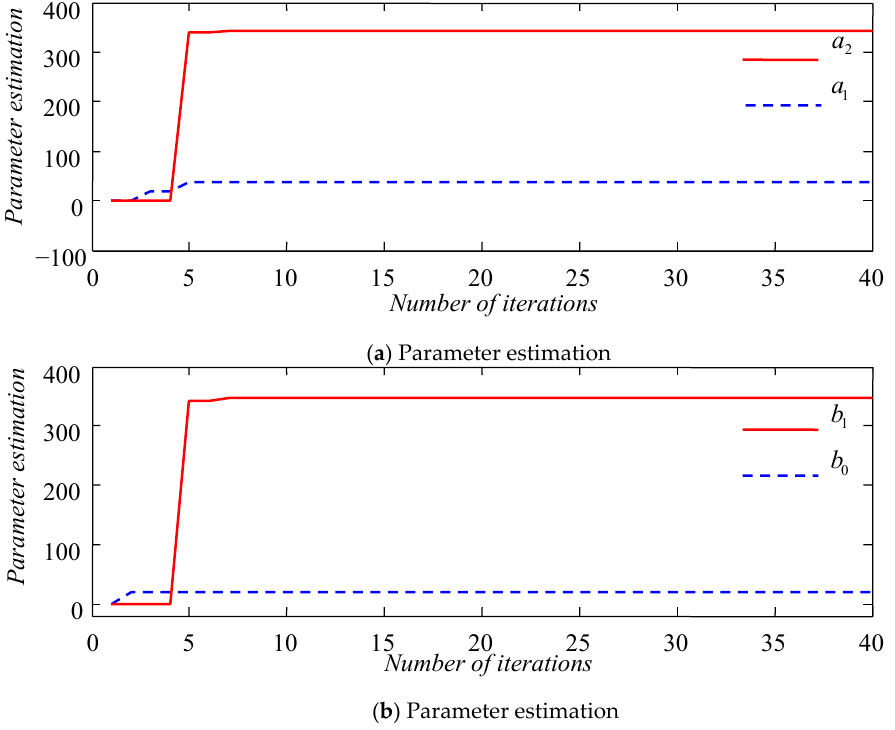
Figure 5. Object parameter estimation results.